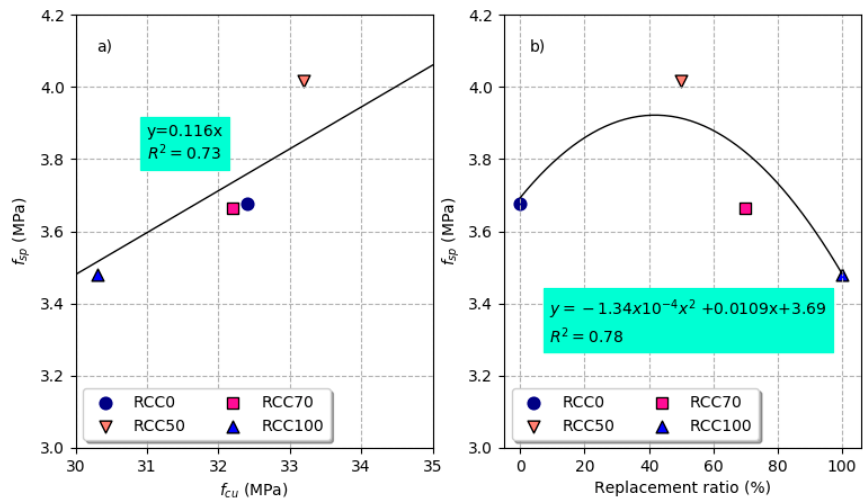
Figure 6. Splitting tensile strength versus ( a ) compressive strength and ( b ) replacement ratio.